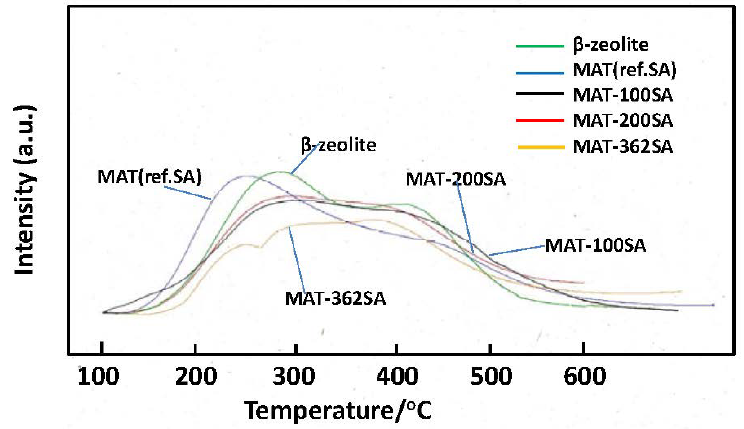
Figure 10. NH -TPD profiles of beta zeolite and mixed 3